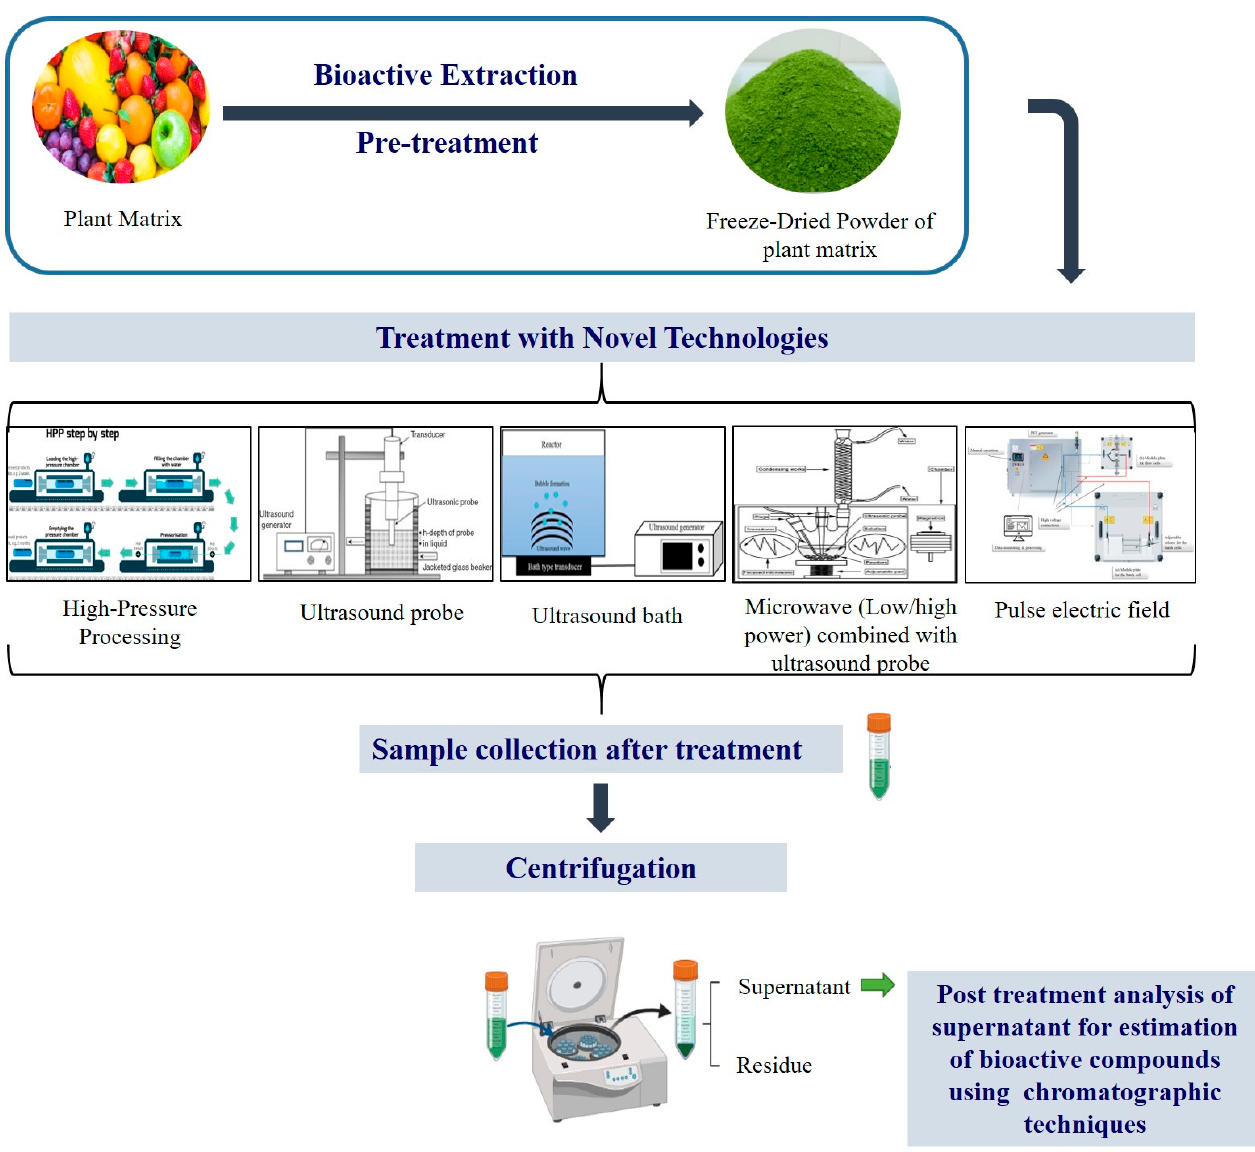
Figure 1. Illustration for the extraction of bioactive compound using novel strategies .